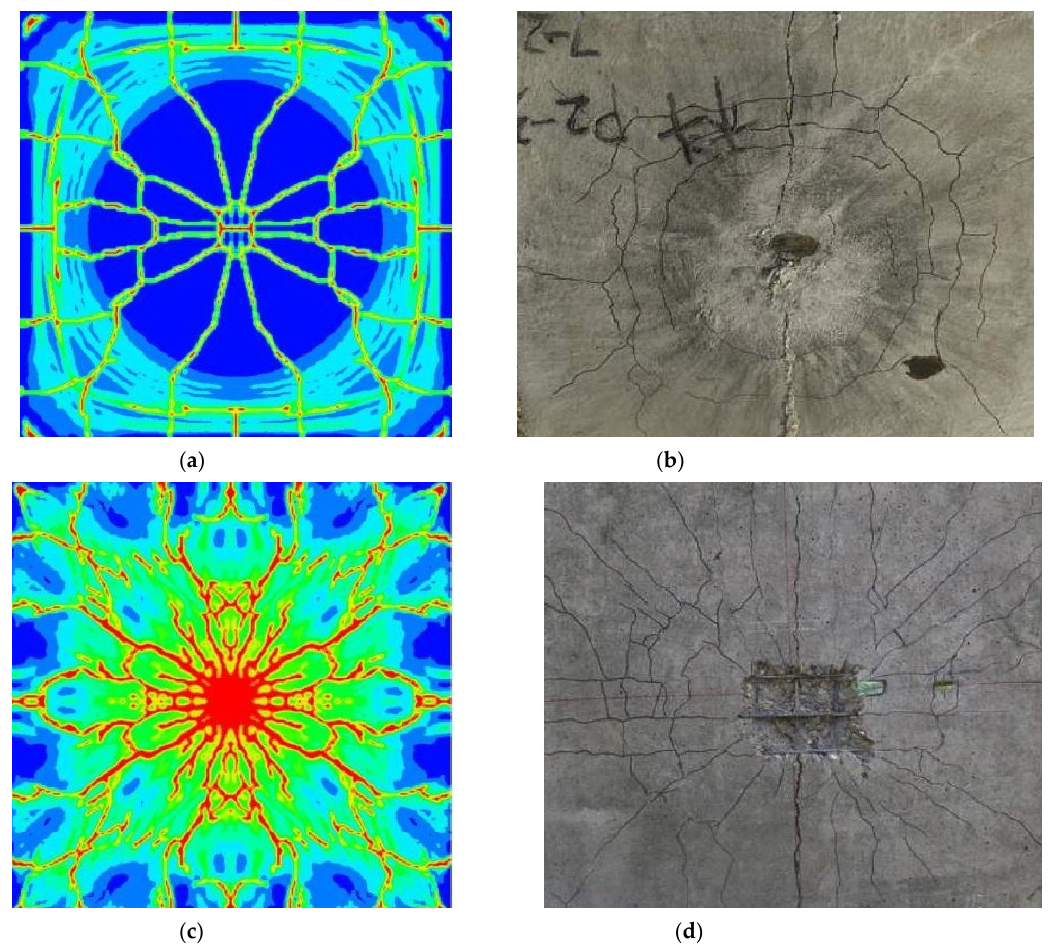
Figure 5. Failure of strengthened concrete slabs under a 0.46 kg TNT blast impact. ( a ) Numerical calculation results of blasting face; ( b ) test results of blasting face. ( c ) Numerical results of the back blasting face; ( d ) test results of the back blasting face.